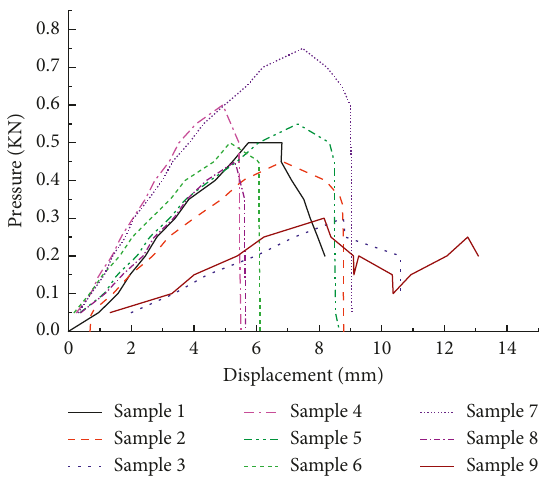
Figure 14: Three-point bending force–displacement curve for each sample.